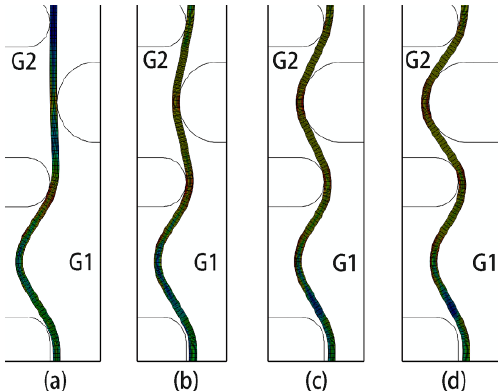
Figure 10. G1 deformation during G2 spinning. ( a ) 0 mm depth; ( b ) 2 mm depth; ( c ) 4 mm depth; ( d ) 5.2 mm depth. Materials 2018 , 11 , x FOR PEER REVIEW